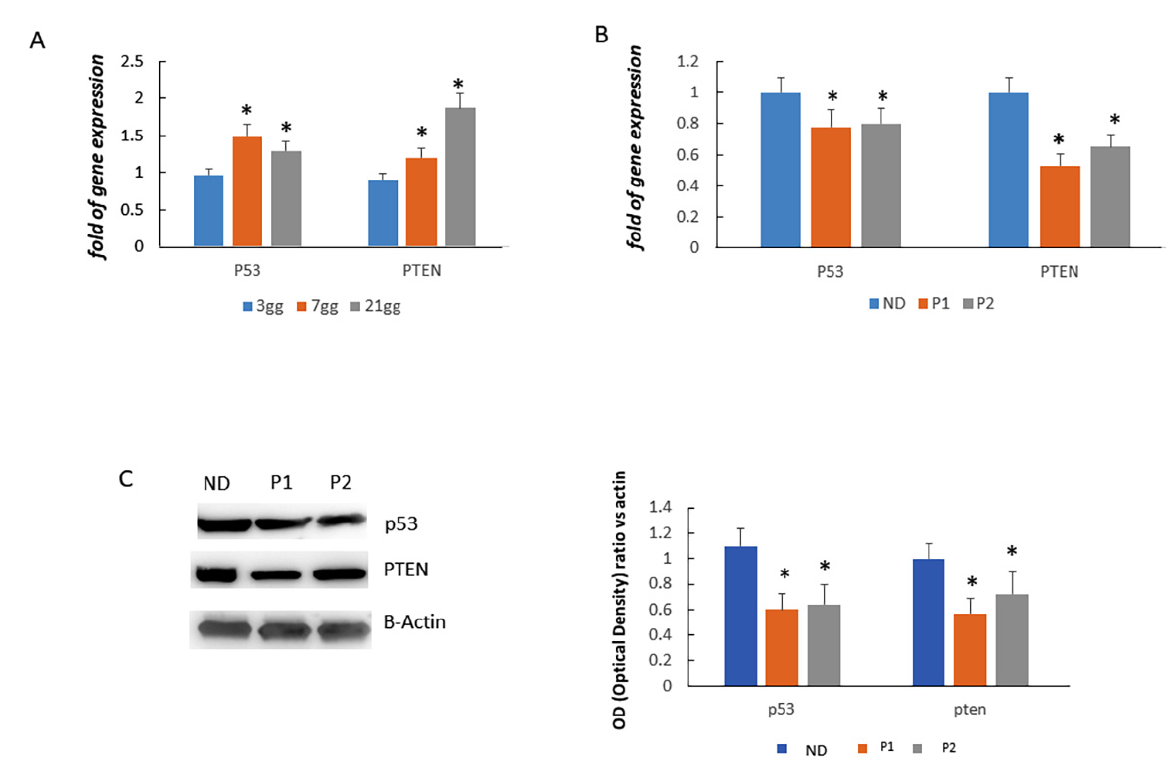
Figure 7. In a control MSC cell line, the expression of P53 and PTEN increased during osteogenic differentiation ( A ). p53 and PTEN gene expression was lower in CCD os-fibroblasts compared to control os-fibroblasts (ND = (normal donor) ( B ). Accordingly, both p53 and PTEN protein levels were lower in CCD os-fibroblasts compared to ND os-fibroblasts ( C ). All analyses were performed (in MSC line or in samples from each participant) in three independent analyses in triplicate. Data are shown as mean ±standard deviation (SD). * p < 0.05.